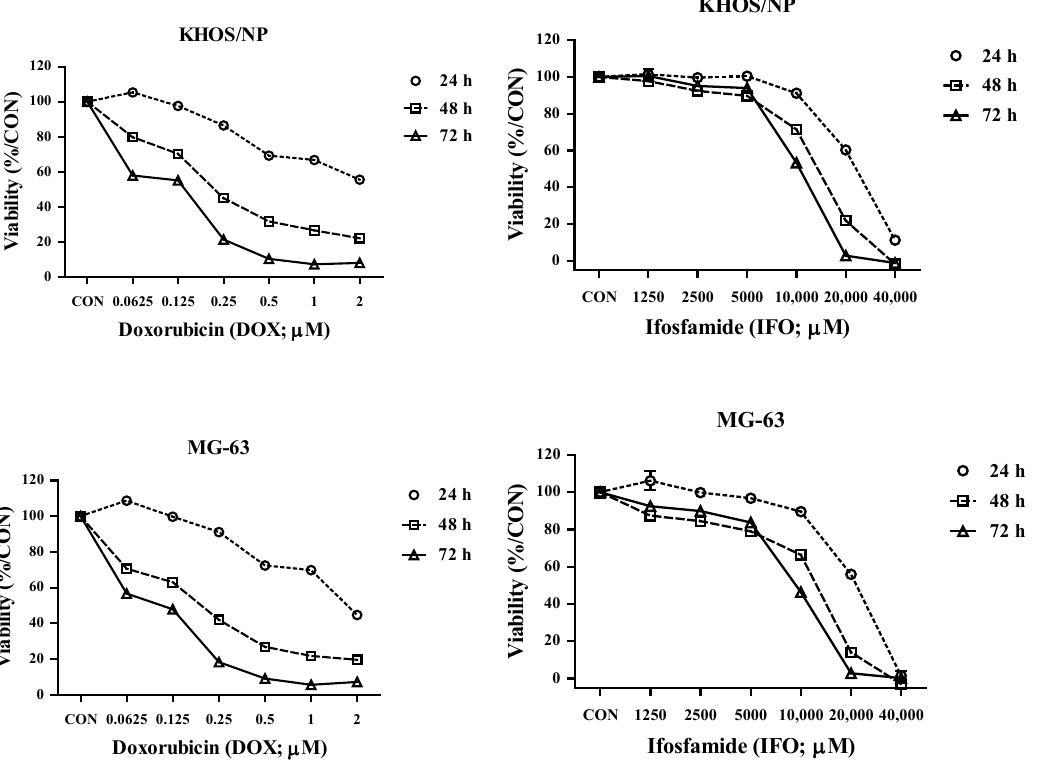
Figure 4. Cytotoxicity of anticancer drugs in osteosarcoma (OS) cells in vitro. KHOS/NP ( upper panel ) and MG-63 ( lower panel ) OS cells were treated with doxorubicin (DOX) or ifosfamide (IFO), and cell viability and IC50 values were measured using the EZ-CyTox cell viability assay kit. The percentages are represented as the mean ±